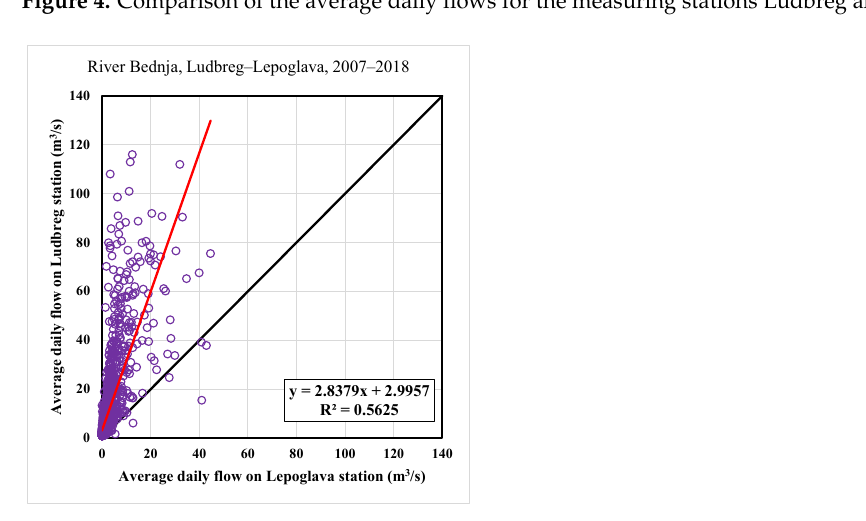
Figure 5. Comparison of the correlation between the measuring stations Ludbreg and Lepoglava.